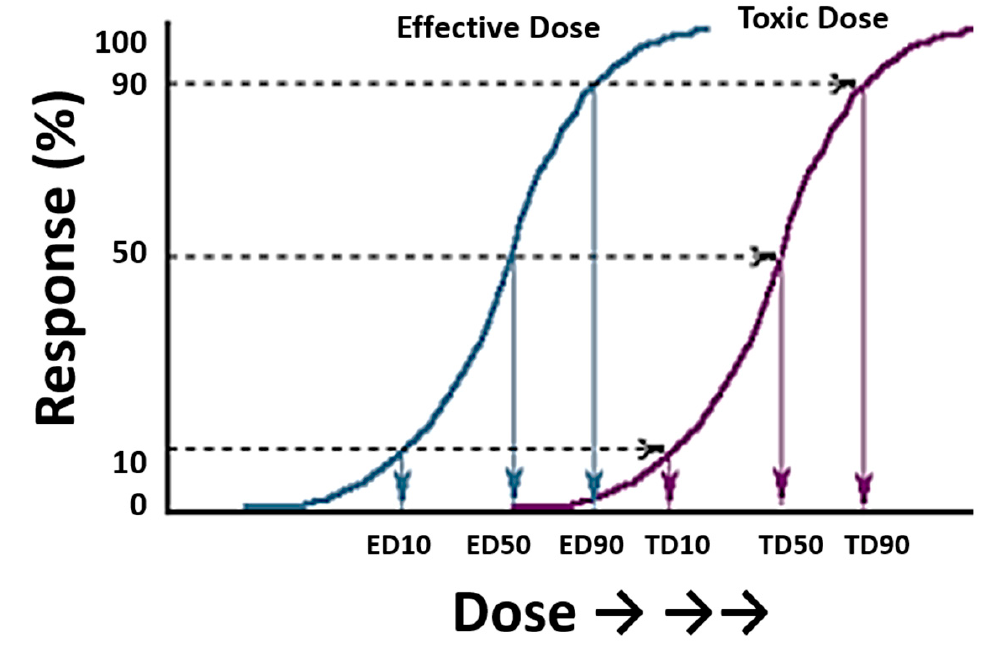
Figure 1. Typical sigmoid curves representing the dose of a drug and its response (measured as a percentage) in a group of individuals. The plot includes two curves relating to effective doses (left) and toxic doses (right). Extrapolation of the response gives the effective and toxic doses (ED and TD, respectively) for 10, 50, and 90% of the individuals exposed to these doses. Figure modified from the Toxicology Teaching Manual of the University of Las Palmas de Gran Canaria with the authors’ permission.